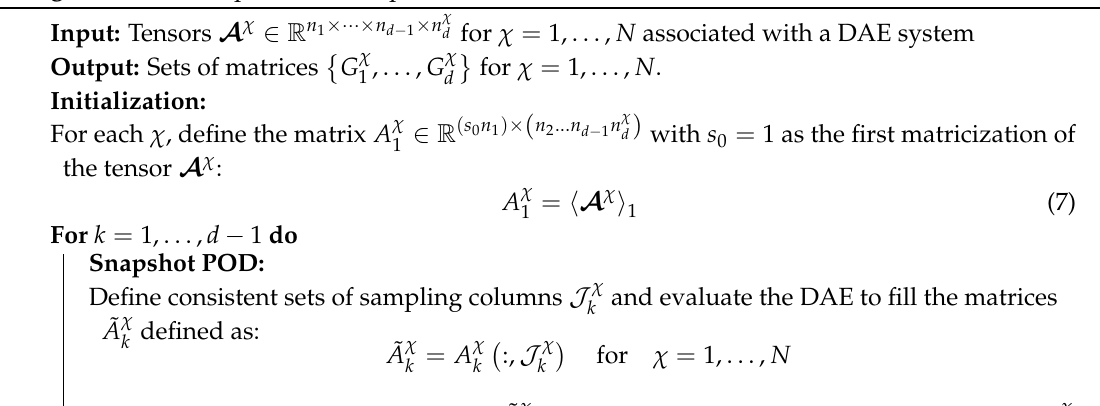
Algorithm 1: Multiple TT